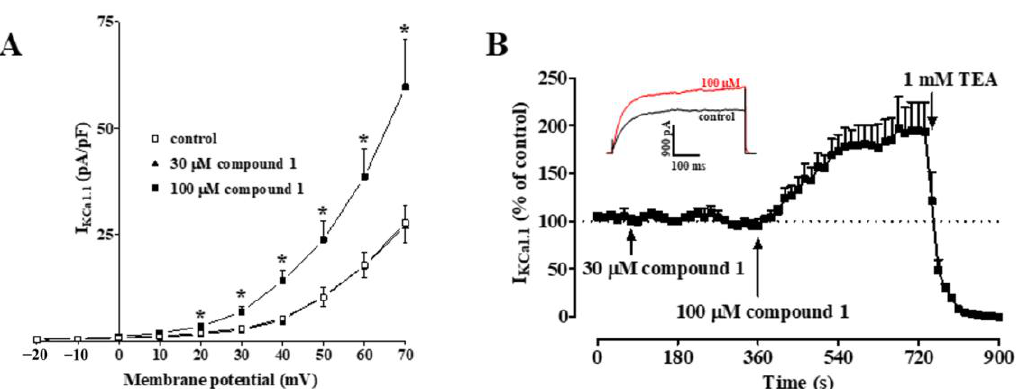
Figure 2. Effects of compound 1 on I KCa1.1 recorded in rat tail artery myocytes. ( A ) Concentration-dependent effect of compound 1 . On the ordinate scale I KCa1.1 amplitude is reported in pA/pF. Data points are means ± s.e.m. ( n = 5). * p < 0.05, repeated measures ANOVA and Dunnett’s post-test vs. control. ( B ) Time-course of current stimulation caused by compound 1 . On the ordinate scale I KCa1.1 is reported as percentage of that recorded just before the addition of the first concentration of the derivative. The effect of 1 mM TEA, which blocked I KCa1.1 , is also shown. Inset: current traces (averaged from 5 cells) recorded in the absence (control) or presence of compound 1. I KCa1.1 was elicited with a clamp pulse to 70 mV from a V h of − 40 mV, delivered every 10 s.